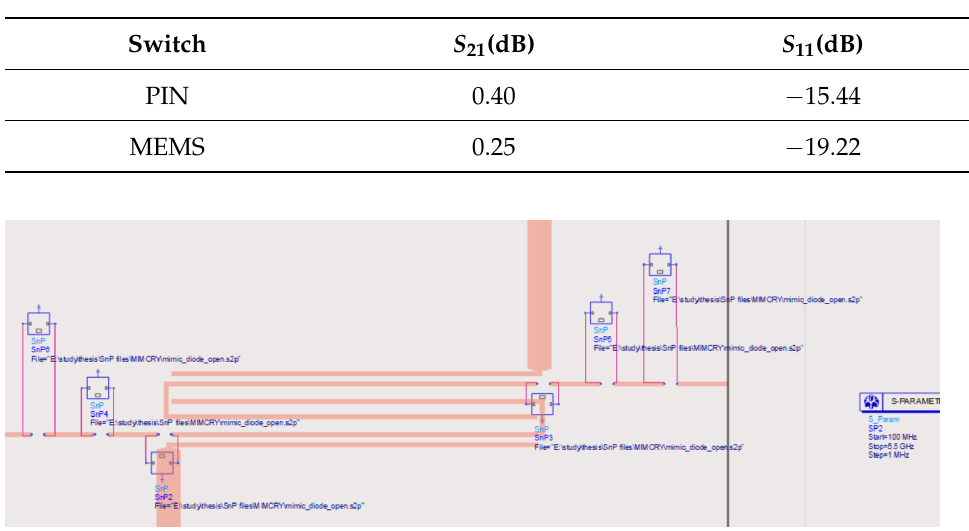
Figure 12. ADS schema of the reconfigurable interdigitated pseudohairpin filter based on